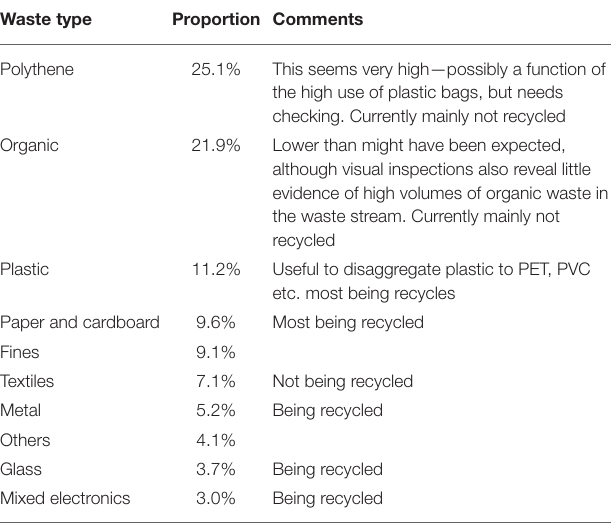
TABLE 1 | Waste composition measured from 162 Households in September